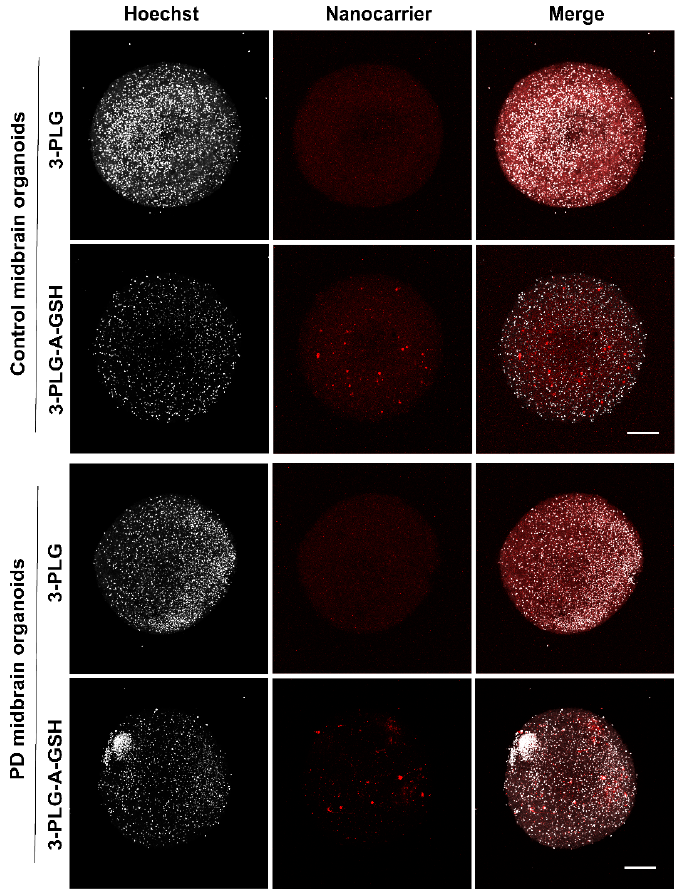
Figure 10. Representative confocal fluorescent microscopy images showing the uptake of non- targeted (3-PLG) and alanine–glutathione-targeted (3-PLG-A-GSH) nanocarriers (red) by midbrain- specific organoids derived from healthy (control) patients and from Parkinson’s disease (PD) pa- tients’ cells after crossing the blood–brain barrier model (24 h, 37 °C). Cell nuclei are stained by Hoechst 33342 (blue). Scale bar: 200 μ m.